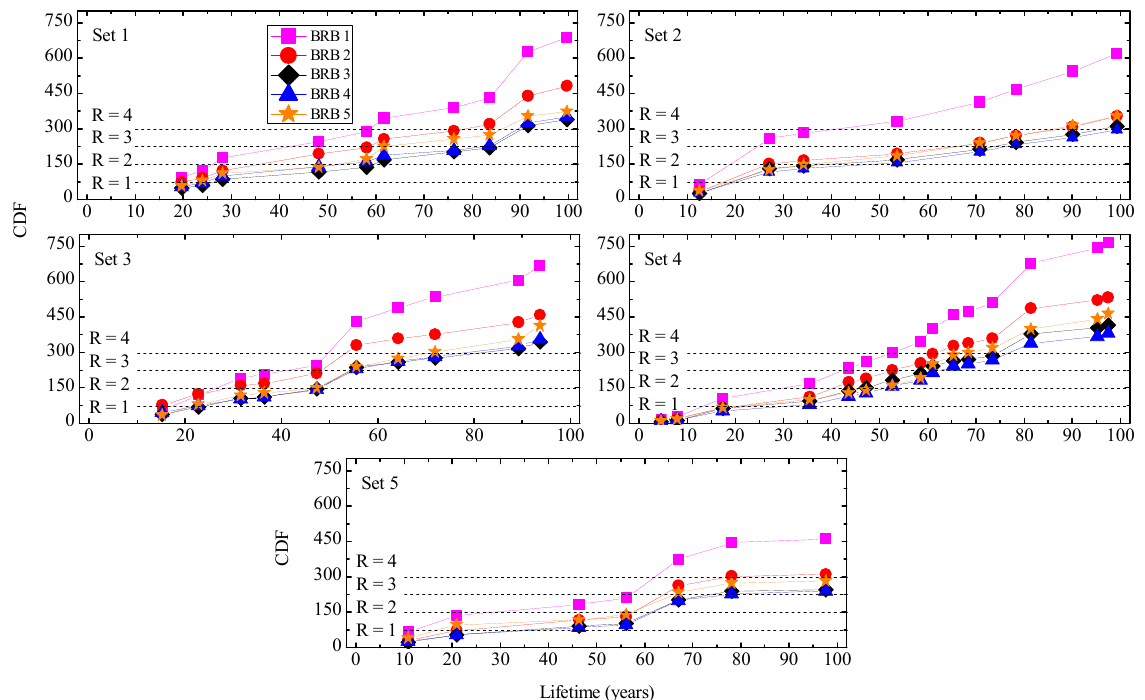
Figure 19. Cumulative ductility factor (CDF) of selected BRBs under multi-hazard scenarios.